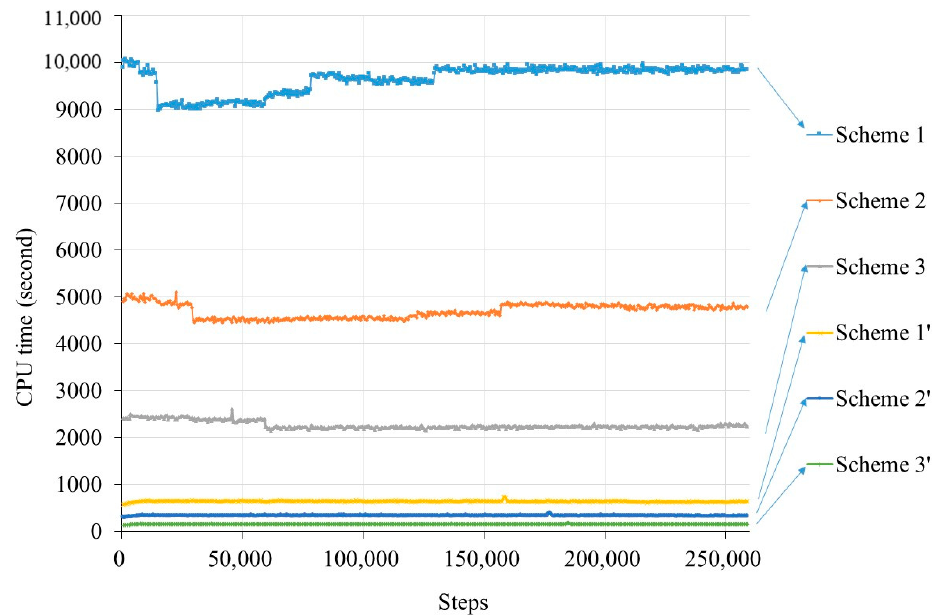
Figure 7. Figure 7. The central processing unit (CPU) time taken for every 500 steps in the 30-day simulation